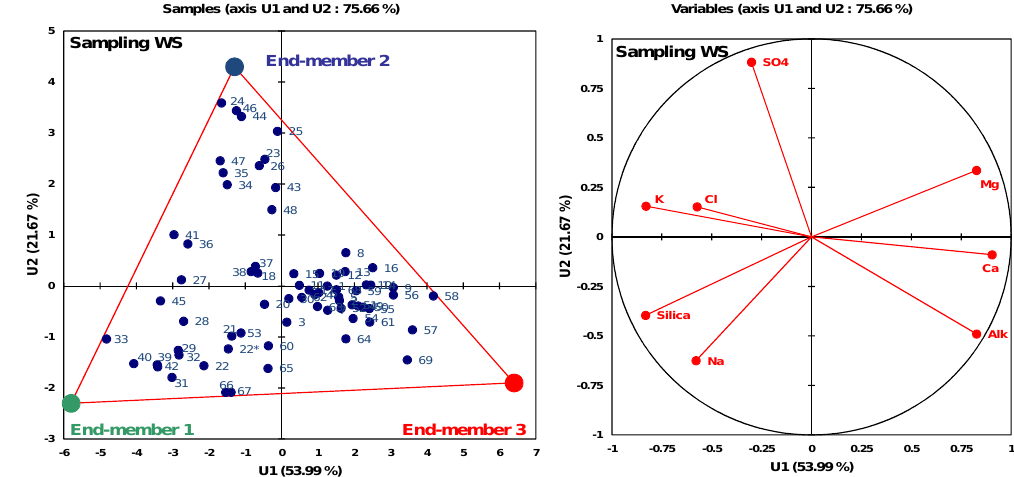
Fig. 8. Samples and variables distributions on the first factorial plan of the PCA 2 carried out on WS sampling.